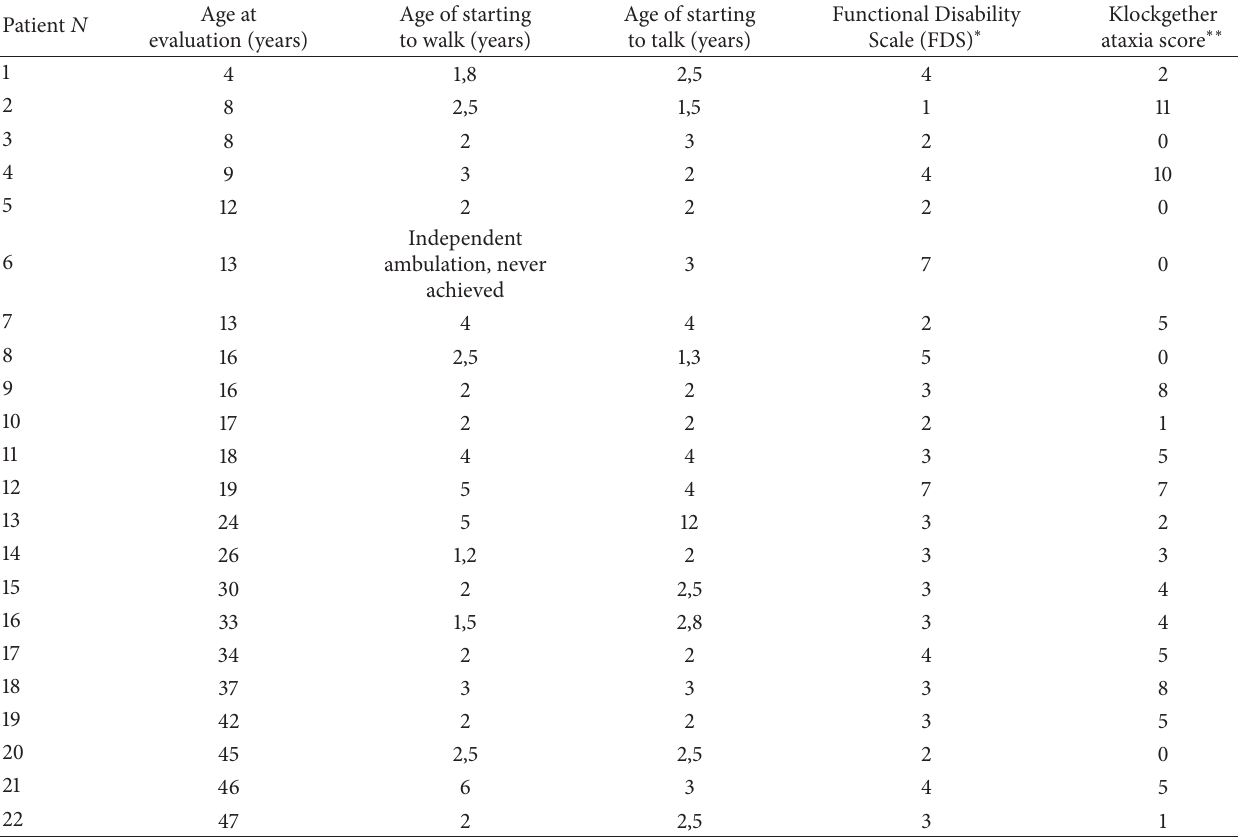
Table 2: Clinical features of CCFDN